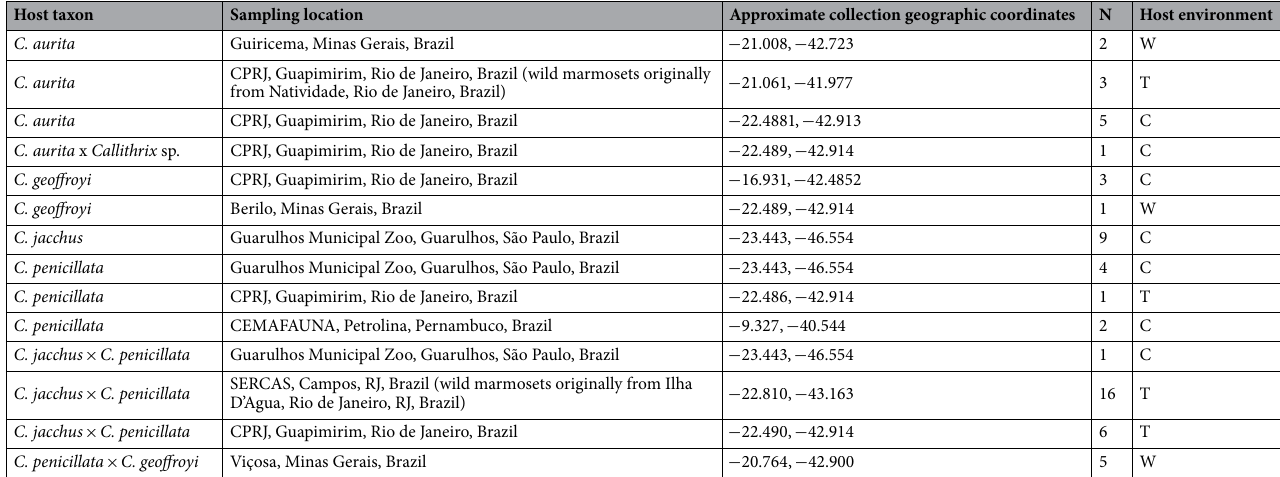
Table 1. Information summary on marmoset host taxon, sampling location, hybrid status, sampling location and environment. For sampling locations, the following abbreviations are used: CPRJ= Centro de